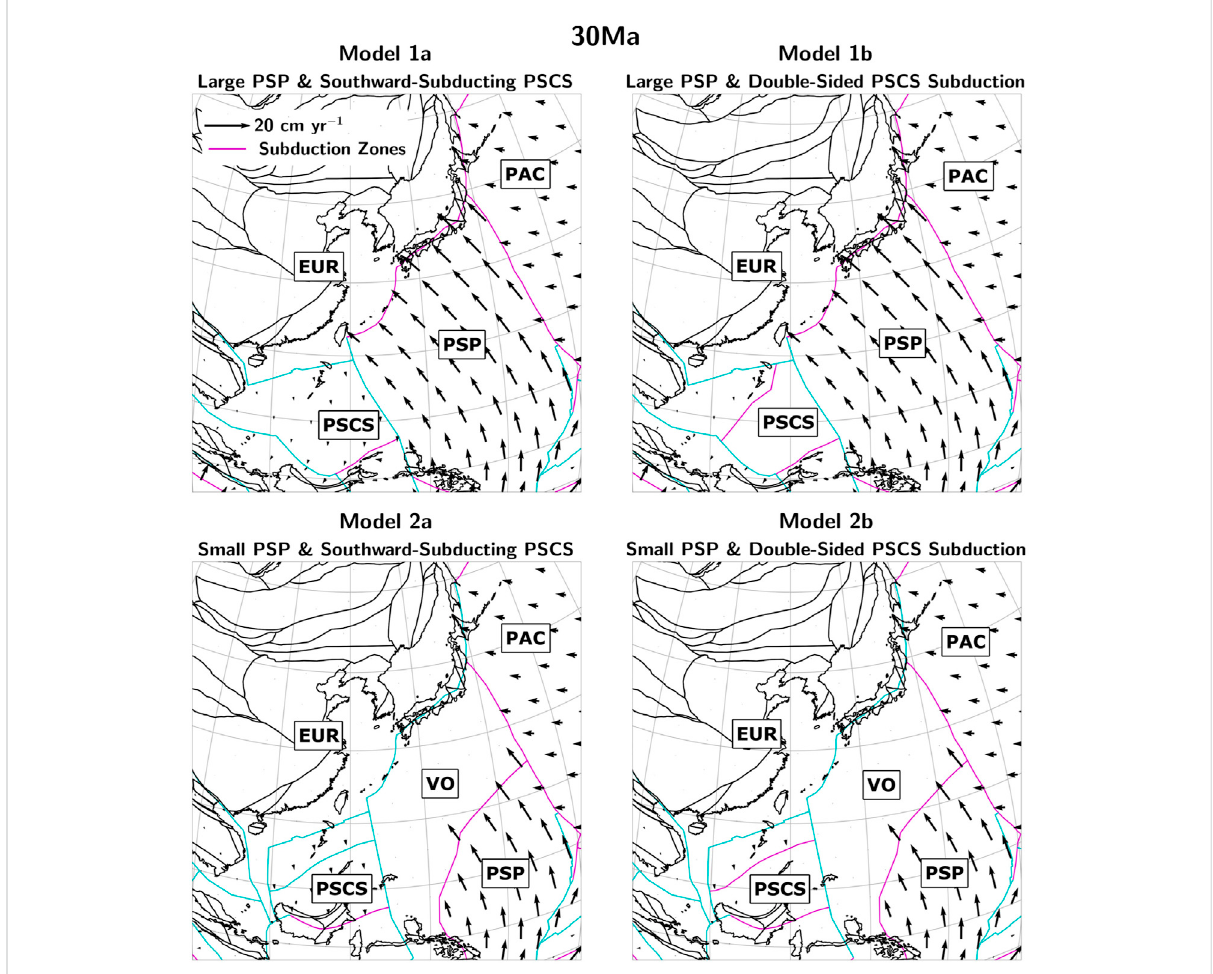
FIGURE 3 30 Ma time-step of the four late Cenozoic tectonic reconstructions used in the mantle circulation models of Lin et al. (2020). Black arrows denoteplatevelocitiesinaglobal movinghotspotreferenceframe (Matthews etal.,2016).Purple linesshow thelocationofsubduction zones,while otherplatemarginsaredrawninlightblue.EUR,EurasianPlate;PAC,Paci fi cPlate;PSP,PhilippineSeaPlate;VO,VanishedOceanPlate;PSCS,proto- South China Sea